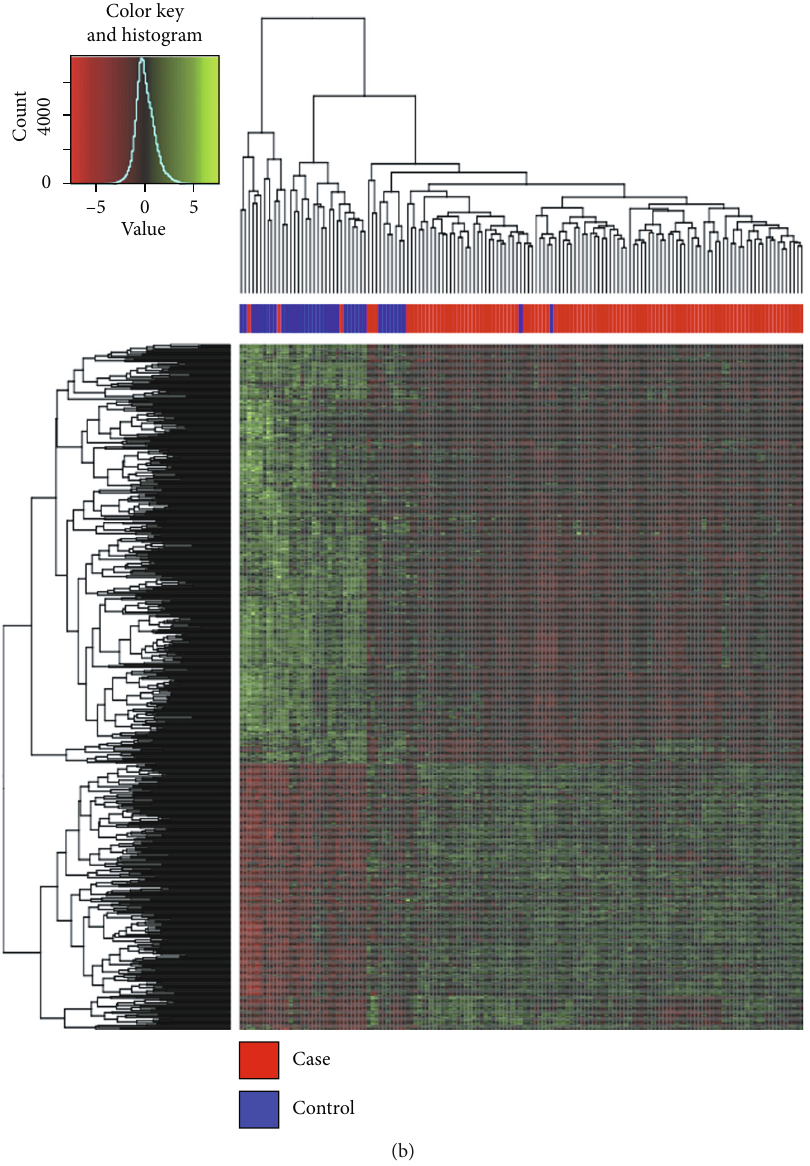
p value. The red and FoldChange, and the ordinate is -log 2 10